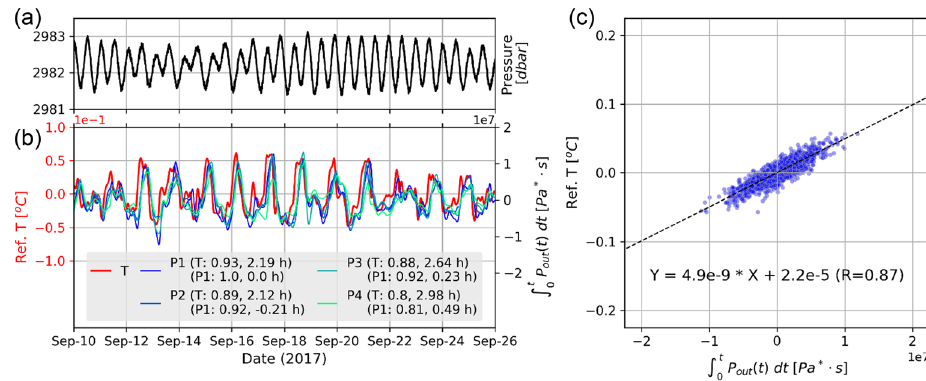
Figure 3. Time-domain comparison between filtered T-sensor and DPG data between September 10 and 25, 2017, with strong inertial internal motions. ( a ) Time series of pressure from the current meter. ( b ) Time series of referenced T-sensor and integrated DPG (DPG-T) data. For each DPG, we show the correlation coefficient and time shifts (in + hours) with respect to the T-sensor (T) and DPG-T P1 (P1), respectively. ( c ) Time shift- corrected DPG-T P1 variations against referenced T-sensor variations for the 15-day period in ( b ). The dashed black line shows the regression line and R is the Pearson correlation coefficient between the referenced T and DPG-T P1 datasets.